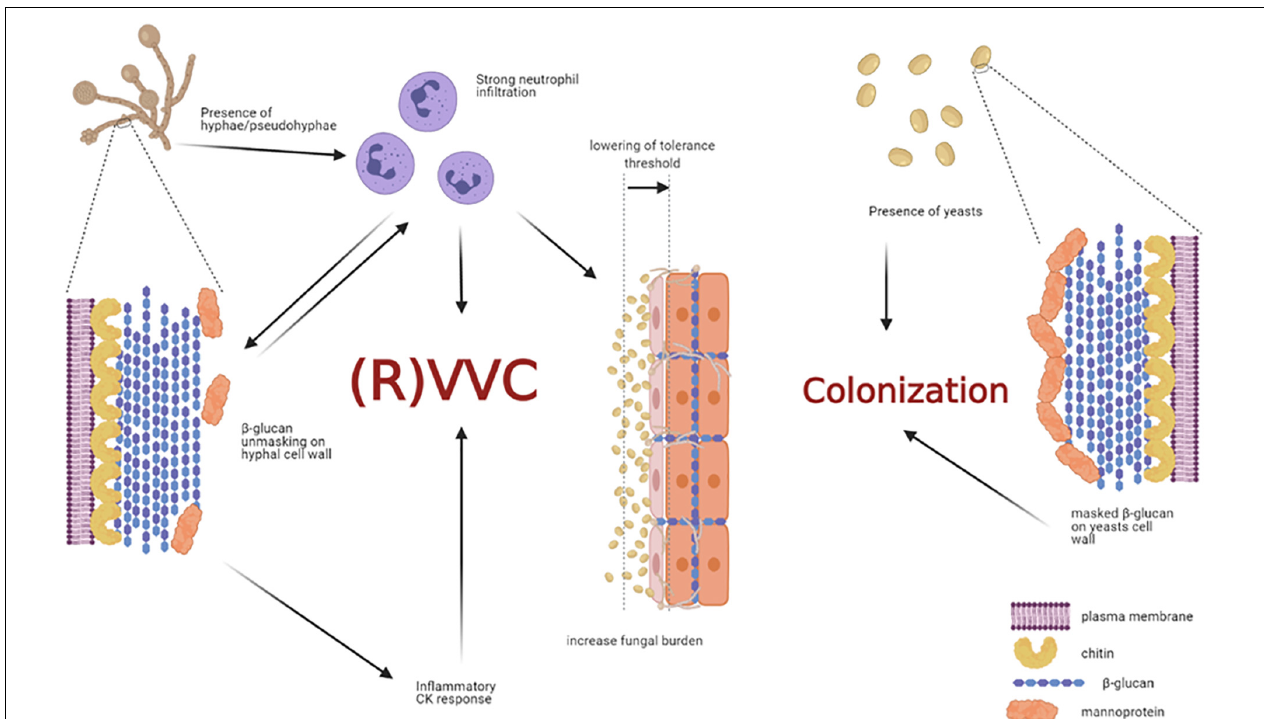
FIGURE 5 | Non-protective immune response triggered by host-fungal interaction. The presence of C. albicans hyphae is a prerequisite for VVC onset, but it may not be sufficient to induce the pathologic process. Indeed, hyphae cause neutrophils recruitment; the latter drive fungal cell-wall changes, such as β -glucan unmasking, which in turn elicits an inflammatory cytokine response. In addition, the interaction of C. albicans hyphae with vaginal epithelial cells further contributes to neutrophils’ recruitment, by overcoming the epithelial tolerance threshold. The neutrophils, which trigger an intense inflammatory response, are unable to clear the fungus and they significantly contribute to VVC onset. Indeed, such massive neutrophils migration to the vagina and the subsequent acute host inflammatory responses are retained to be the main responsible for the symptoms of VVC. Differently, the presence of C. albicans yeasts do not cause neutrophils recruitment, β -glucan unmasking does not occur, and the host-fungal interaction ends up in a colonization process (created with BioRender.com).